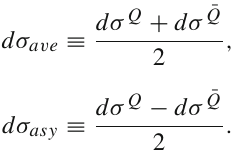
Fig. 6 Unpolarizedandpolarizedcrosssectionsforbottomproduction on RHIC. a and b are the unpolarized cross sections for 500GeV, respectively. c is the polarized cross section. In all of these cross sections, we have set rapidity and azimuthal angle of heavy quark